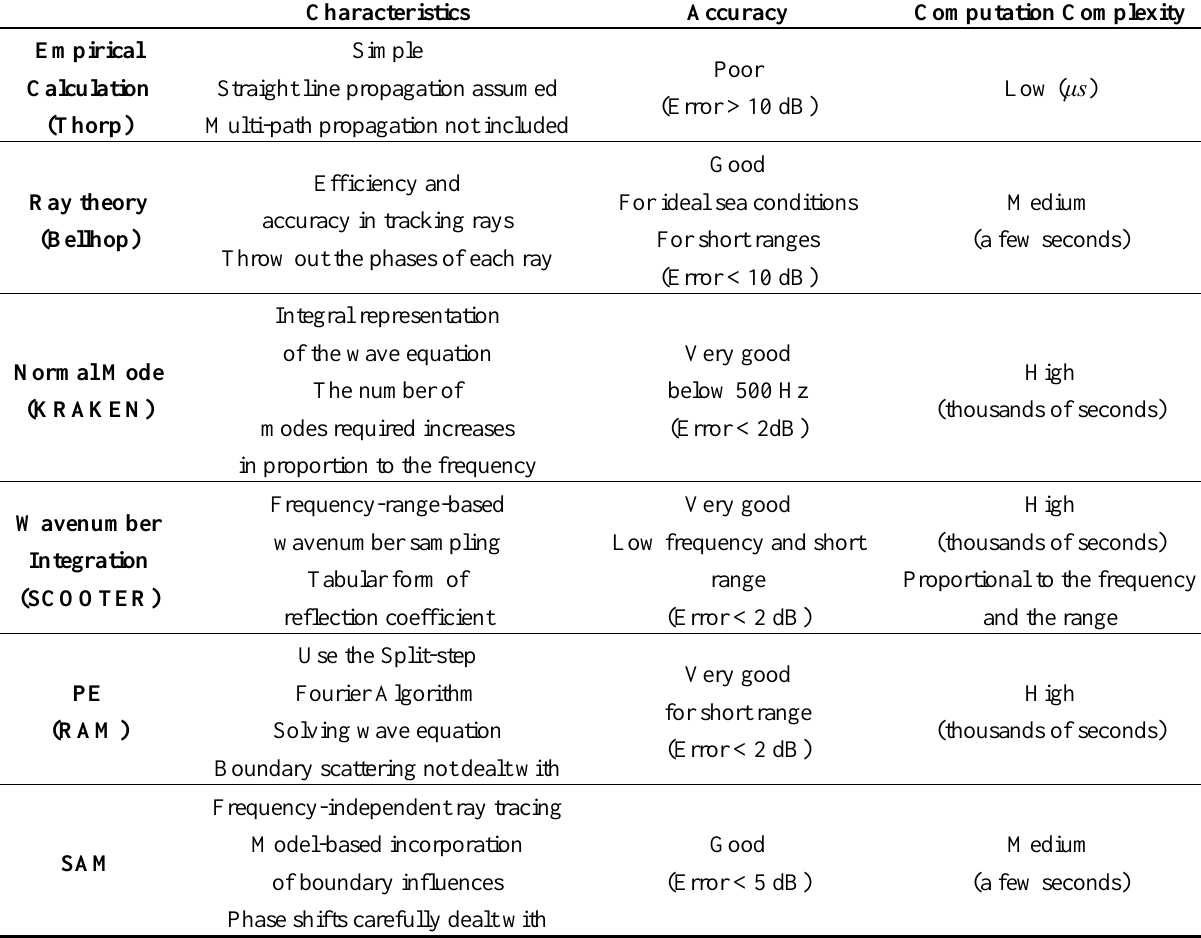
Table 2. Comparisons of different computation models for transmission